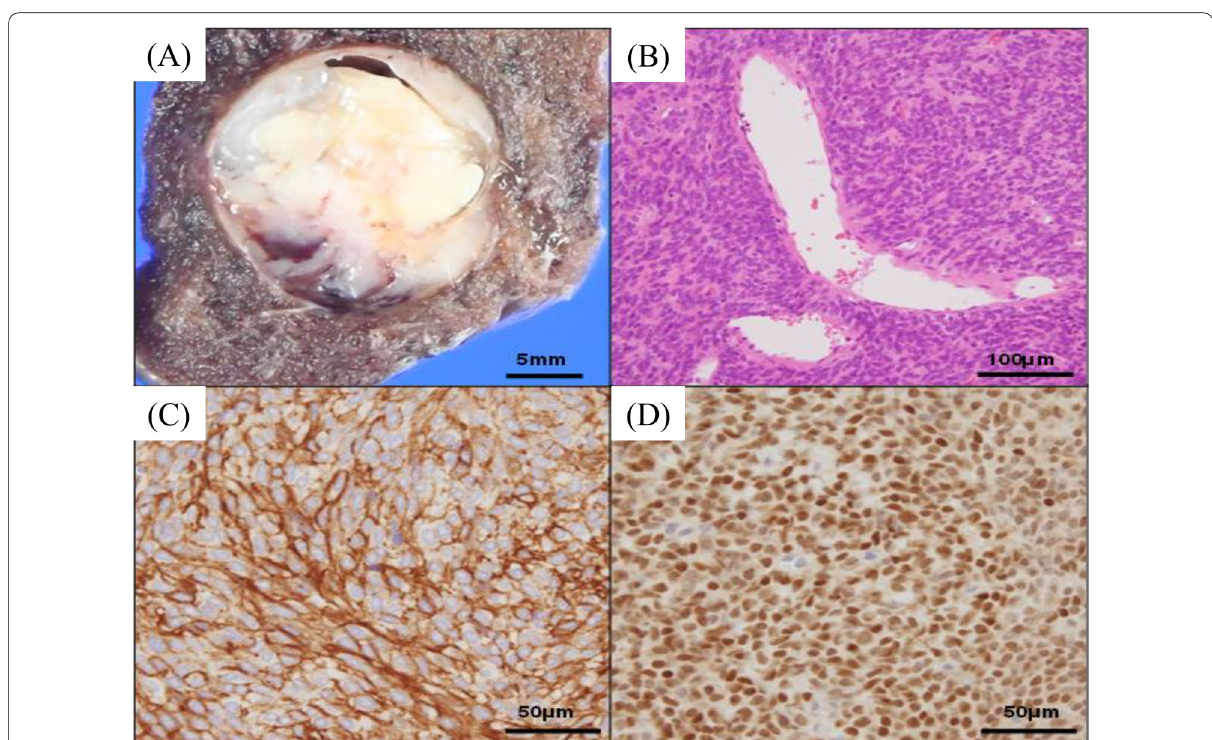
Fig. 2 Macroscopical photograph shows a well-circumscribed tumor with white–yellow cut surface without involving the pleura ( A ). Microscopically, short spindled to oval cells proliferate in pattern-less pattern with branching vessels and collagenous stroma ( B , hematoxylin and eosin stain). Immunohistochemically, the spindled tumor cells are diffusely and strongly positive for CD34 ( C ) and STAT6 ( D